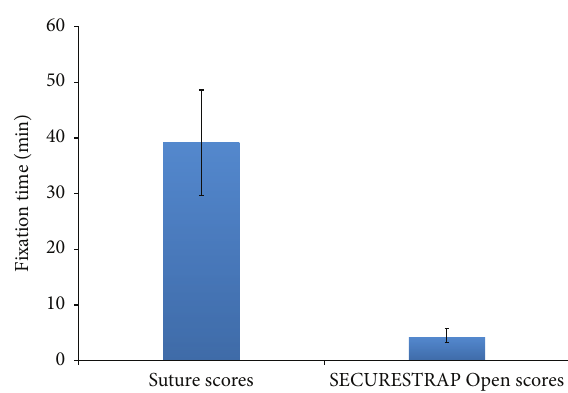
Figure 1: Time scores for suture and mechanical fixation